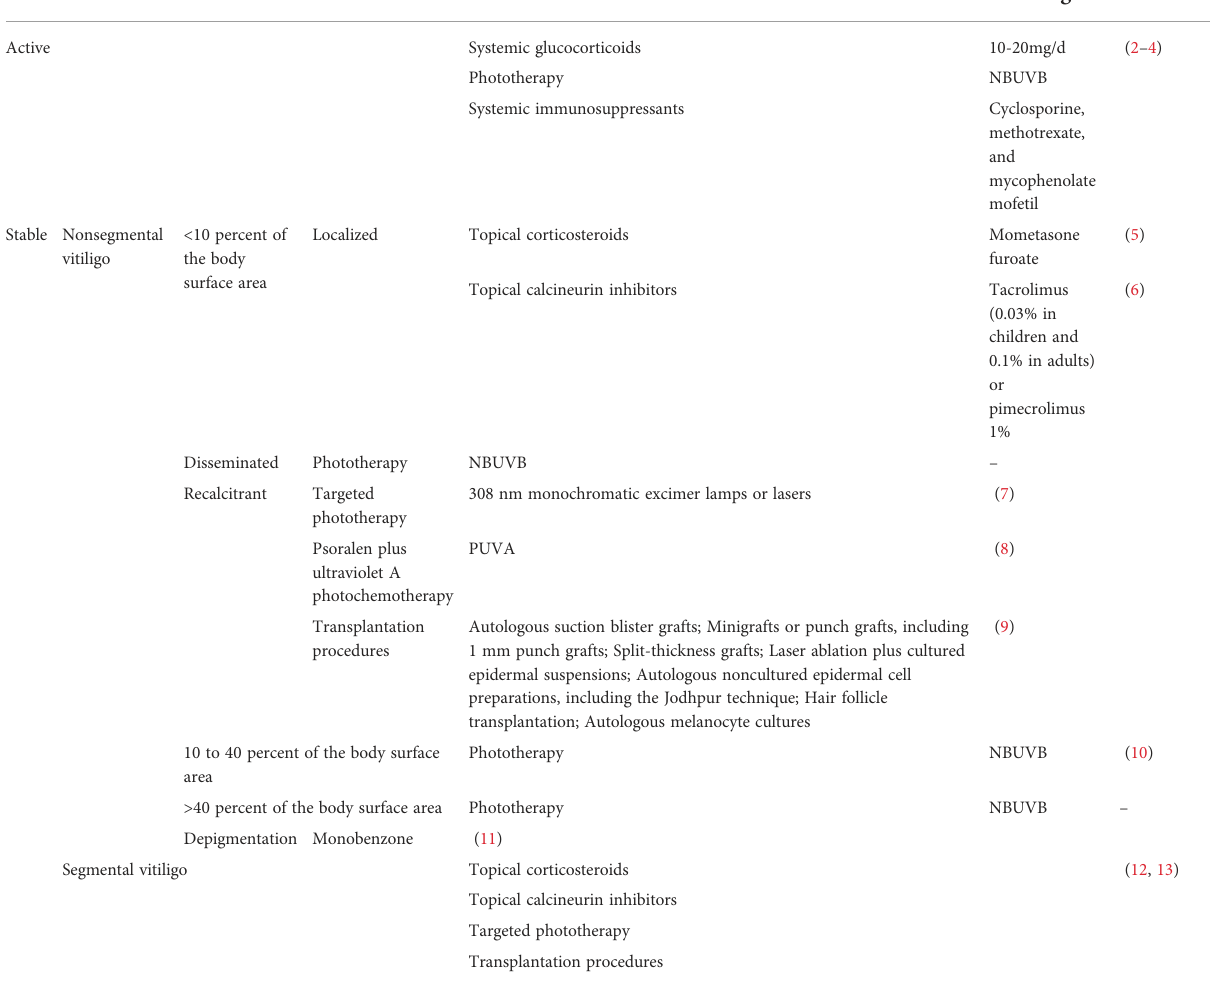
TABLE 1 Current treatment modalities for